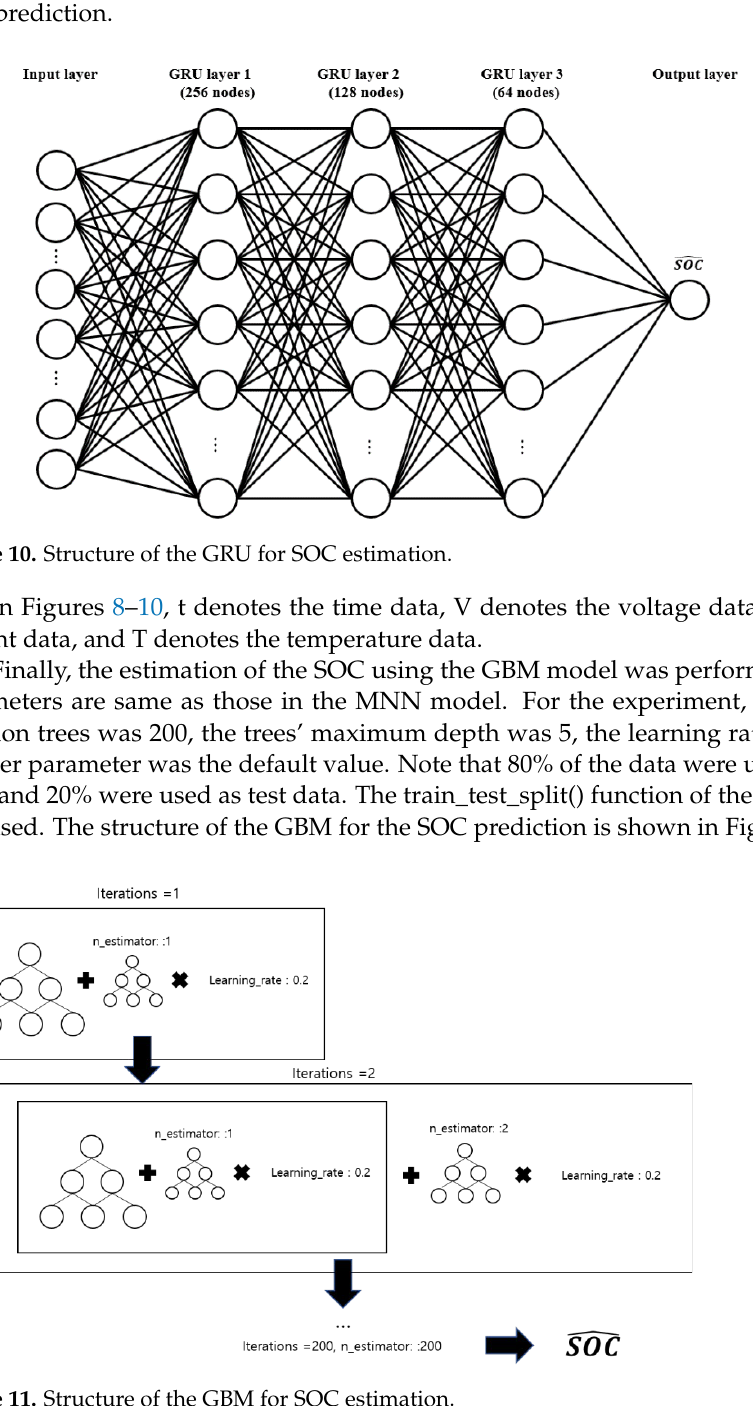
Figure 9. Structure of the LSTM for SOC estimation.